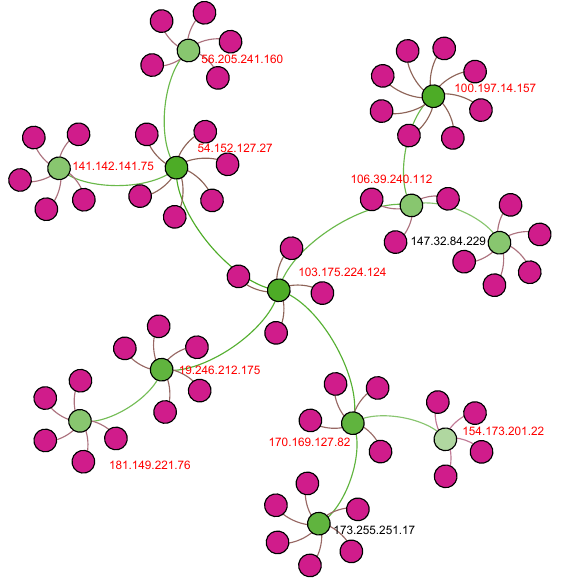
Figure 8. Complete cascading motif captured from the TCP worm test.